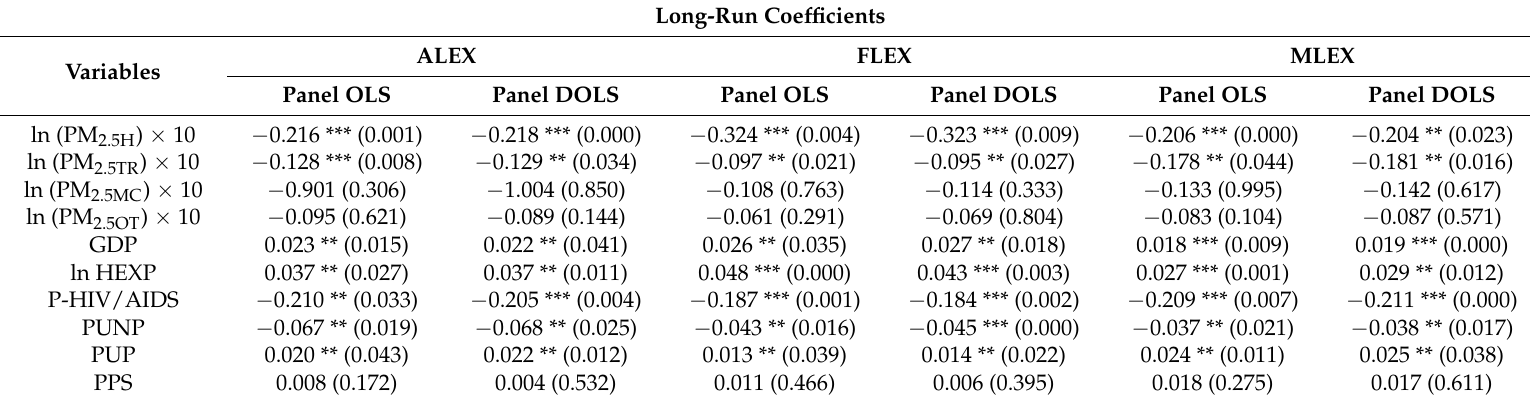
Table 4. Estimates of long-run coefficients for aggregate life expectancy (ALEX), female life expectancy (FLEX) and male life expectancy